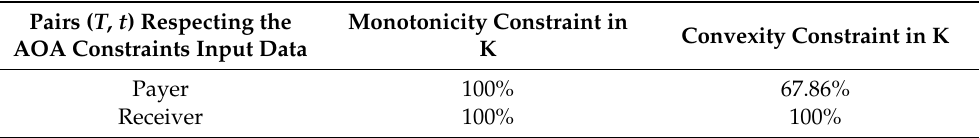
Table 1. Percent of pairs ( T , t ) respecting the absence of arbitrage in strike constraints defined in Proposition